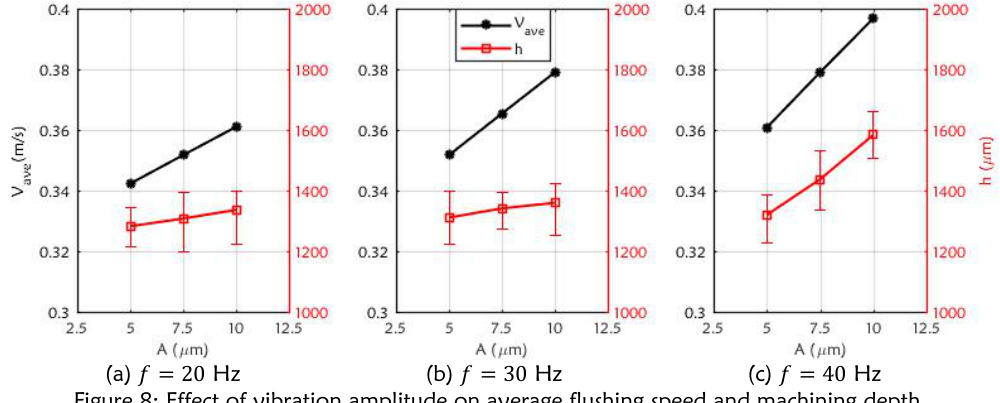
Figure 8: Effect of vibration amplitude on average flushing speed and machining depth